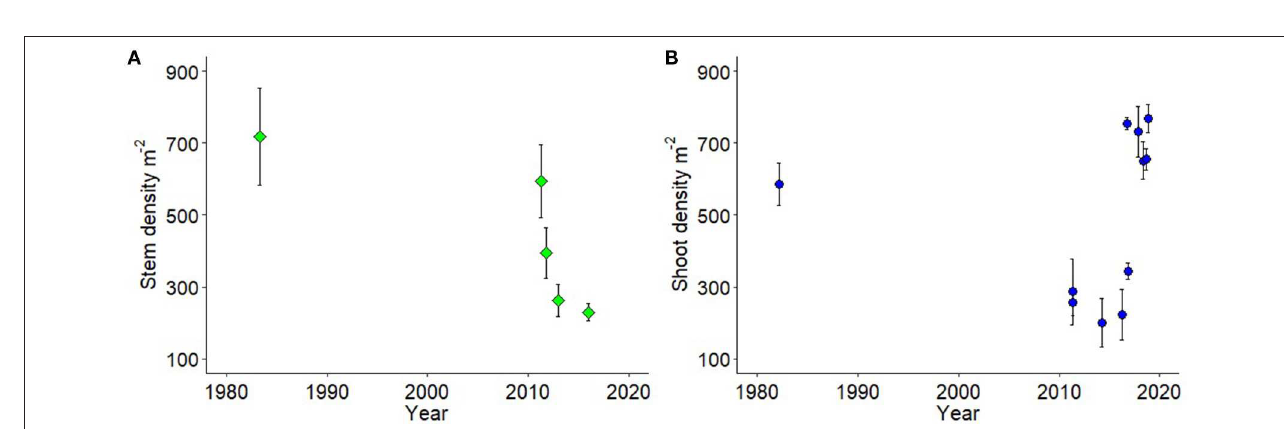
FIGURE 4 | (A) A. antarctica shoot density (m − 2 ; green diamond) from four field programs in the Eastern Embayment from Herald Bight to southern Faure Sill, and 1 from the Western Embayment; and (B) P. australis shoot density (m − 2 ; blue circles) from 11 field programs across the Western Embayment but also